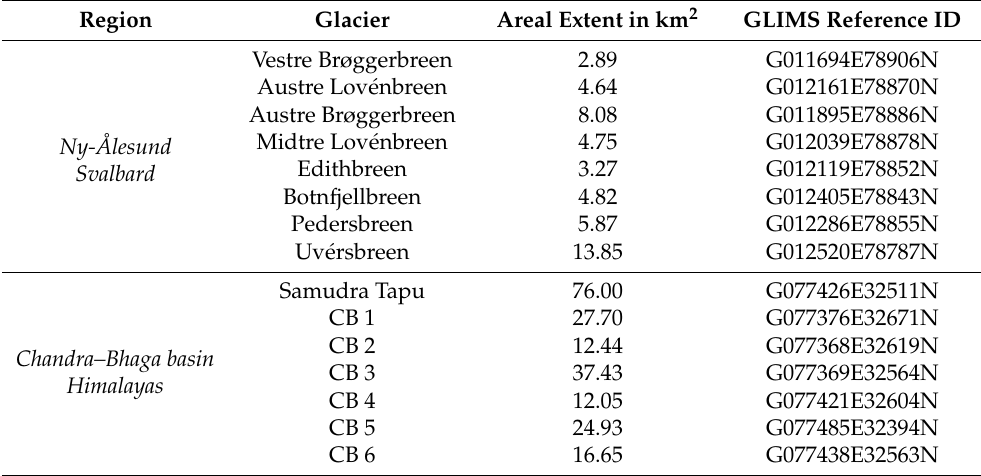
Table 1. The selected glaciers of the study, their areal extents, and GLIMS reference IDs. The areal extents were calculated from the delineated shapefiles using the geometry calculator in